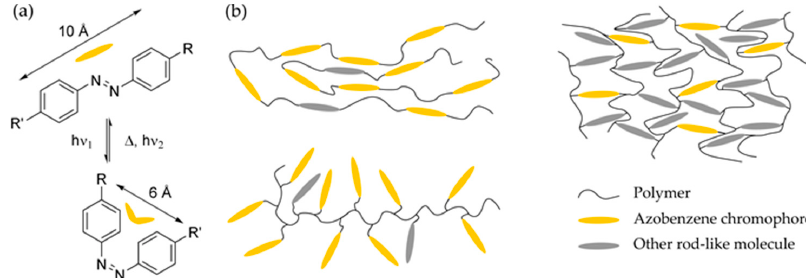
Figure 1. ( a ) Photo-isomerization of azobenzene; ( b ) Schematic representation of the azobenzene containing polymeric systems : linear polymers (top, left), side-chain polymers (bottom, left) and liquid crystal polymer networks